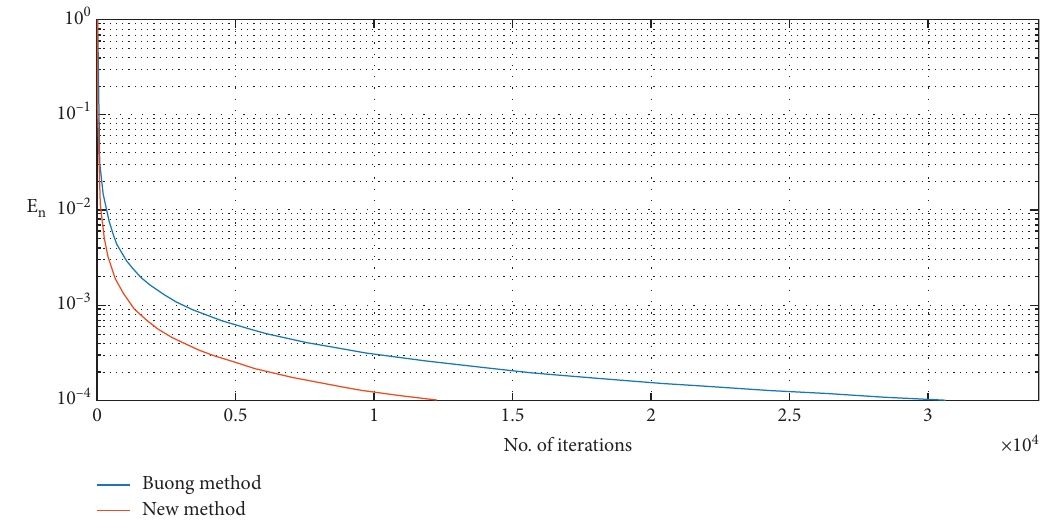
(− 2 , 1 ) T . n with the initial point